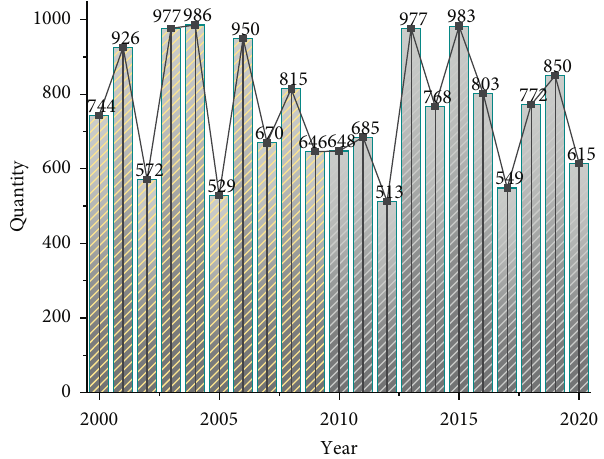
Figure 8: Annual trends in the publication of literature on “telecommunications network